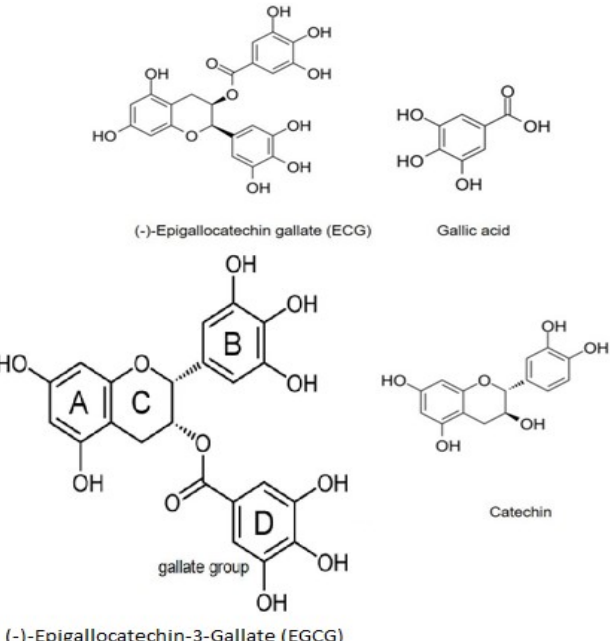
Figure 2. Chemical Structure of EGCG and its progenitors. The chemical makeup of EGCG contributes to its ROS reducing and anti-inflammatory properties. EGCG comprises 4 rings denoted A, B, C, and D. A and C form the benzopyran ring, which has a phenyl group at C2 and a gallate group at C3. The B ring has positional 3, 4,5-trihydroxyl groups, and the D ring galloyl moiety (gallate group) is configured as an ester at C3. The B and D rings have contributed to their ROS deactivating properties. The D ring has been shown to be associated with anti-inflammation and anticancer char- acteristics.